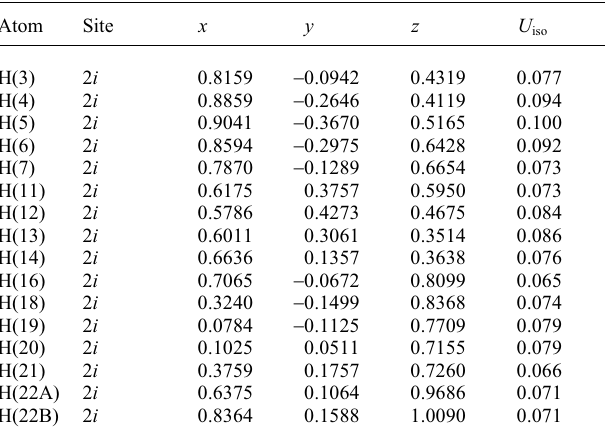
Table 2. Atomic coordinates and displacement parameters (in Å 2 )